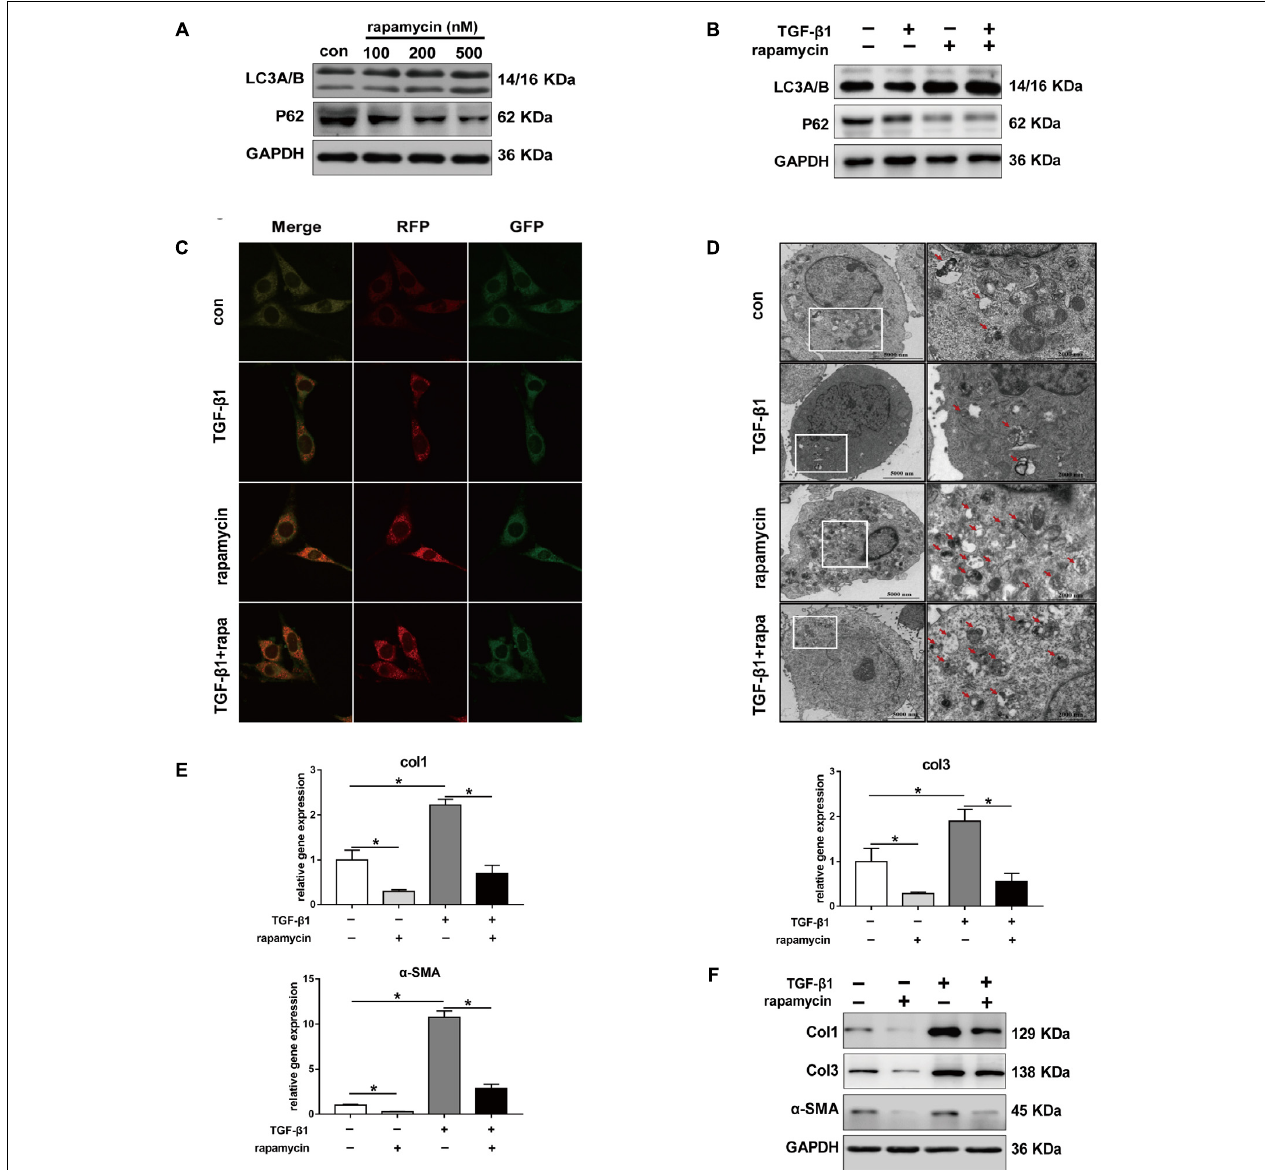
FIGURE 6 | Rapamycin regulates fibrotic gene expression in NIH/3T3 fibroblasts. (A) Representative images of western blot analysis of LC3A/B and p62 protein levels after different concentration of rapamycin treatment for 24 h. (B) Representative images of western blot of LC3A/B and p62 levels after TGF- β 1 (2 ng/ml) and/or rapamycin (500 nM) treatment for 24 h. (C) Representative images of fibroblasts stably transfected with GFP-RFP-LC3 were treated with TGF- β 1 and/or rapamycin. Images were obtained by confocal microscope. Green and red-positive puncta indicate autophagosomes; green-negative, red positive puncta indicate autophagolysosomes. (D) Representative images of fibroblasts were treated with TGF- β 1 and/or rapamycin, then autophagic vesicles (AVs) were analyzed by transmission electron microscope. (E) mRNA and (F) protein levels of Col1, Col3, and α -SMA after treated with TGF- β 1 and/or rapamycin. Data are shown as the mean ± SD of three independent experiments. ∗ P <